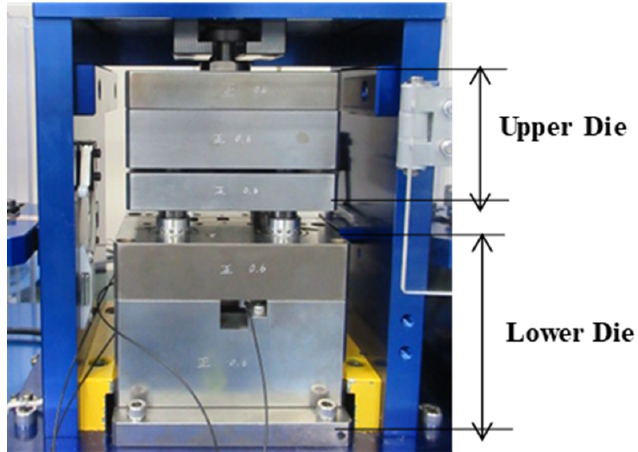
Figure 3. Fine stamping system with a sub-micrometer positioning capacity.